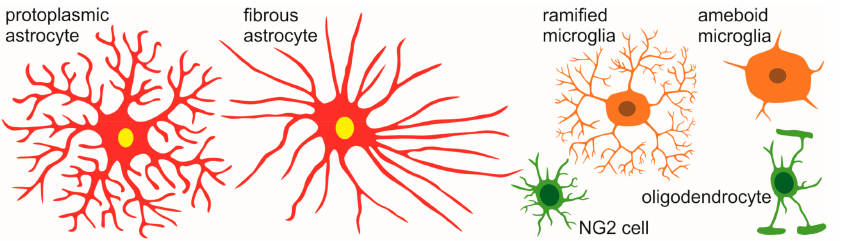
Figure 1. Main types of glia cells in the